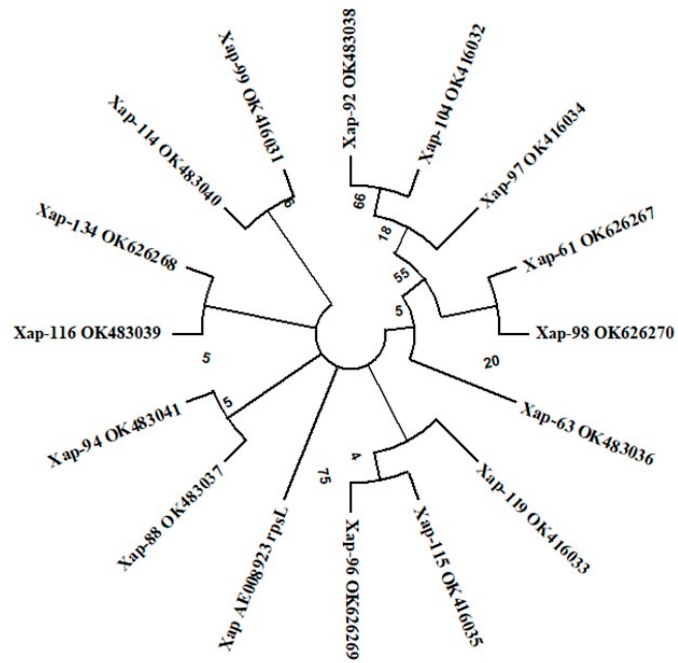
Figure 7. Neighbor-joining tree on the basis of amino acid sequences using Max Lil.